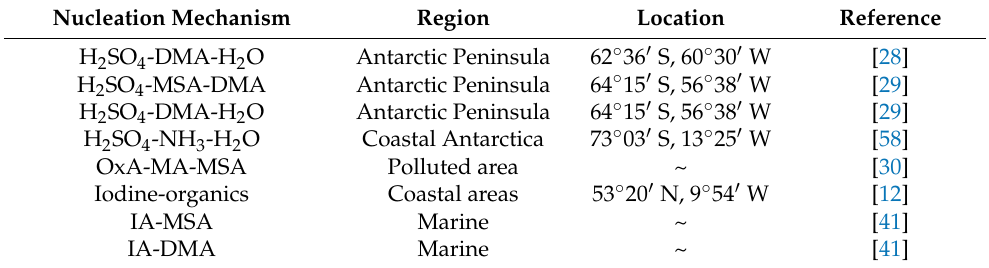
Table 3. Summary of the reported NPF mechanisms over the SO and